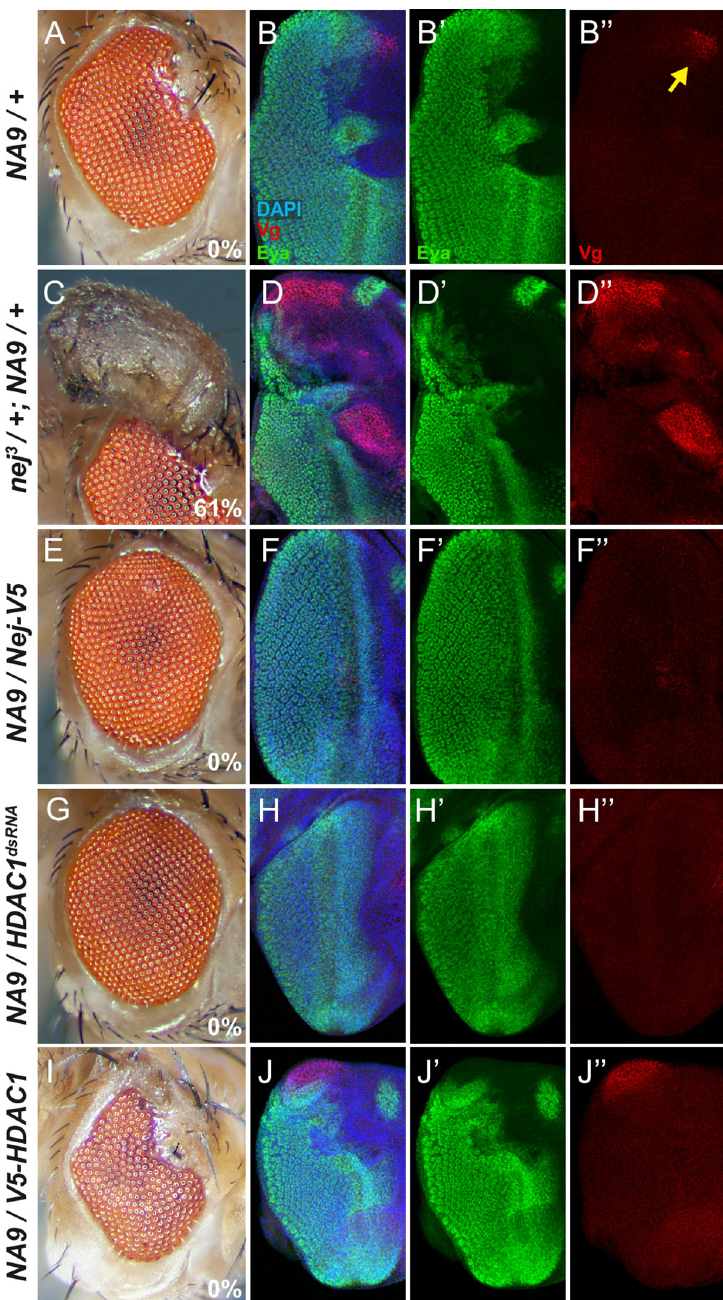
Fig 7. Drosophila CBP/p300 and HDAC1 activity influence NA9 -mediated transdetermination. (A, C, E, G, I) Micrographs of adult Drosophila eyes. (B, D, F, H, J) Third instar larval eye discs immunostained with anti-Vestigial (Vg) and anti-Eyes Absent (Eya) antibodies. DAPI staining marks the nuclei. The following genotypes were analyzed: (A, B) ey-Gal4 , UAS-NA9/+ . (C, D) nej 3 /+; ey-Gal4 , UAS-NA9 /+. (E, F) ey-Gal4 , UAS-NA9 /+; UAS-Nej-V5/+ . (G, H) ey-Gal4 , UAS-NA9/UAS-HDAC1 dsRNA . (I, J) ey-Gal4 , UAS-NA9/+; UAS-V5-HDAC1/+ . Proportion (%) of eyes exhibiting ectopic wing material is indicated at the bottom right of each eye micrograph. Quantifications are shown in Table 2. Yellow arrow points to the anterior dorsal margin exhibiting Vg